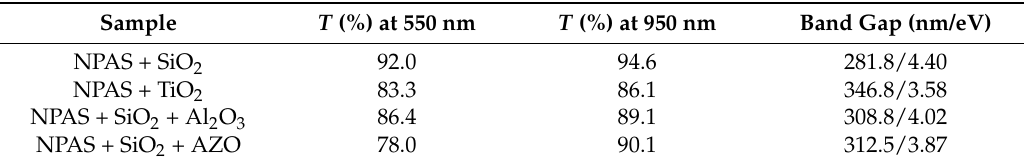
Figure 3. Variation of light transmittance with wavelength for: NPAS + SiO 2 (cyan); NPAS + TiO 2 (black); NPAS + SiO 2 + Al 2 O 3 (yellow); NPAS + SiO 2 + AZO (pink) samples; and the NPAS support (grey dashed line). The inset shows the transmittance % for the lowest wavelength interval (200–500 nm). Table 3. Values of light transmitted % at two wavelengths (550 and 950 nm) and the band gap for the studied nanoporous alumina based structures.